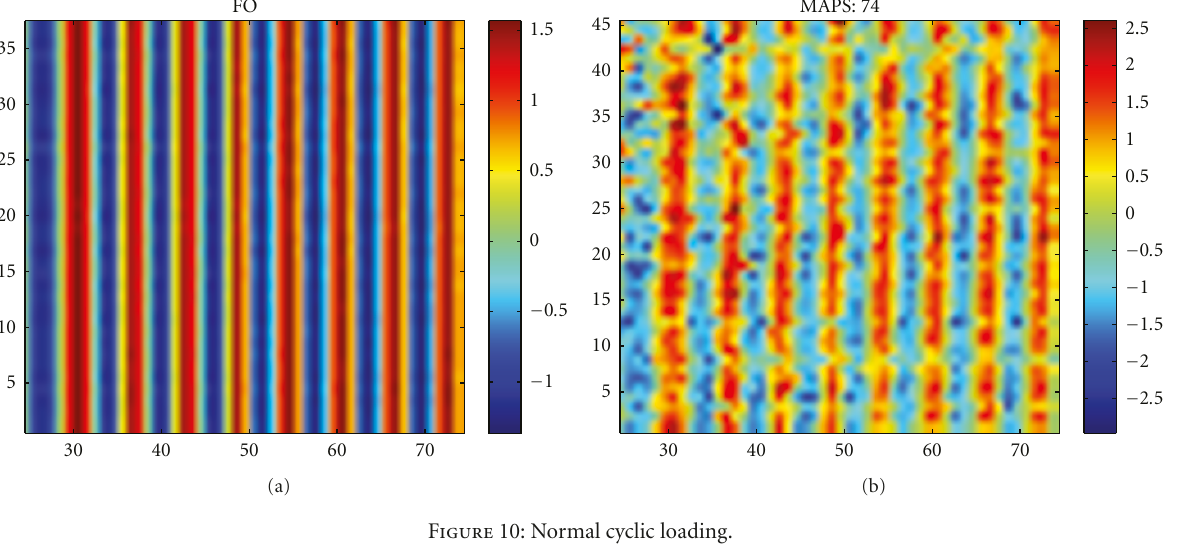
Figure 10: Normal cyclic loading.